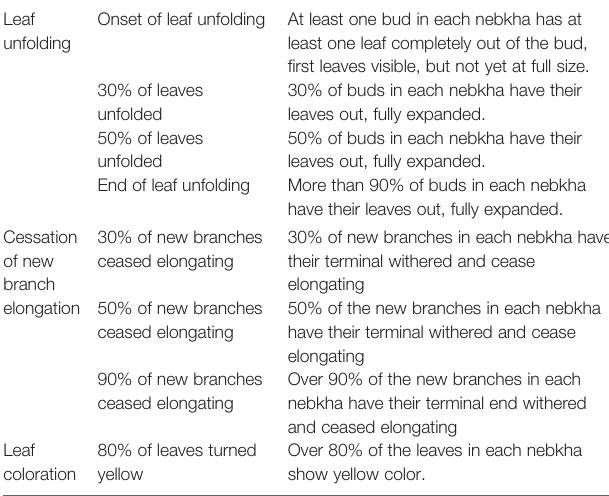
TABLE 2 | Phenological events recorded in this study. All shrubs in each treatment plot (nebkha) were considered and counted. Leaf